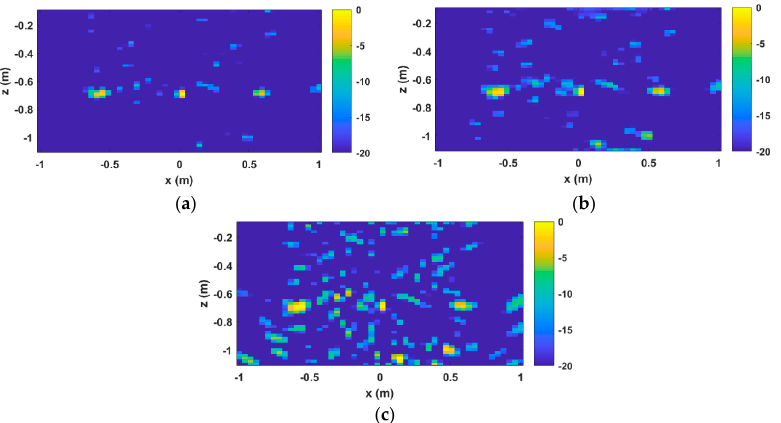
Figure 4. Reconstruction results at an SNR (signal-to-noise ratio) of − 10 dB for three-targets scene using two transmitters and six receivers. ( a ) GSR (group sparse reconstruction); ( b ) TVM (total variation minimization); ( c ) standard 𝑙 (cid:2869) ‐ norm minimization.